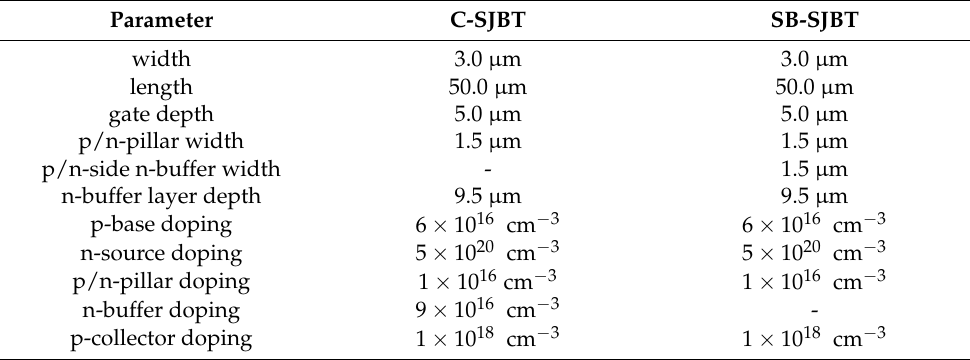
Figure 1. Structure of ( a ) C-SJBT and ( b ) proposed SJBT with separated n-buffer layers. Table 1. Device parameters for the simulations.